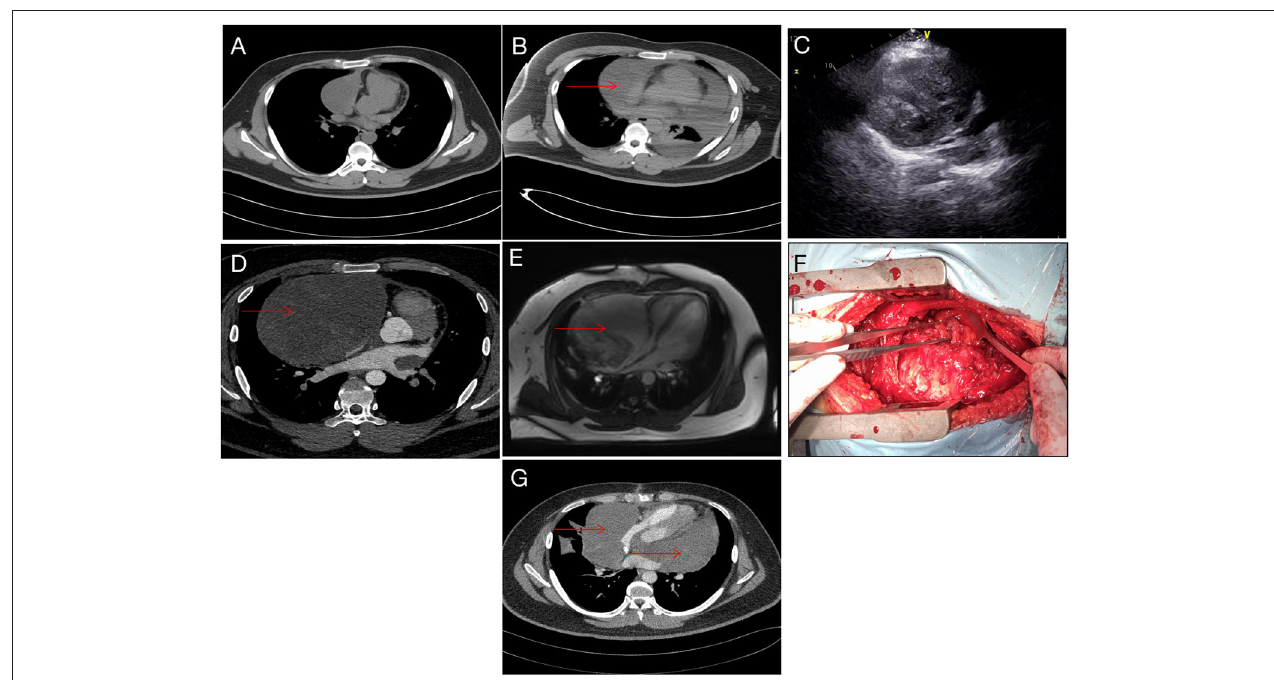
FIGURE 1 | Imaging data. (A) CT image taken during the first admission. (B) After pericardiocentesis, CT indicating a suspicious mass (red arrow). (C) Echocardiography showing pericardial space-occupying lesions. (D) Reexamination after 5 months showed obvious space occupation (red arrow). (E) Preoperative magnetic resonance imaging, right pericardium, showing a cystic mass (red arrow). (F) During the operation, the tumor filled the pericardial cavity. (G) Tumor recurrence noted 5 months after operation (red arrow).